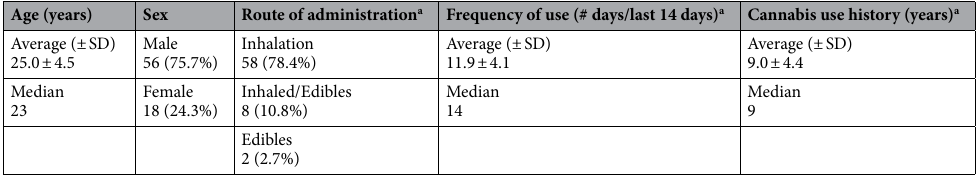
Table 1. Clinical subject demographics. a Six subjects (8.1%) did not report route of administration, frequency of use, or use history.